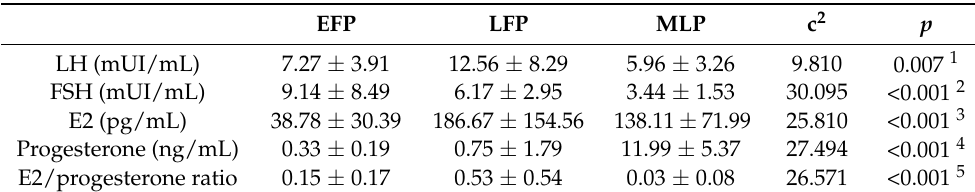
Table 1. Sex hormone concentrations (Mean ± SD) on the testing days.